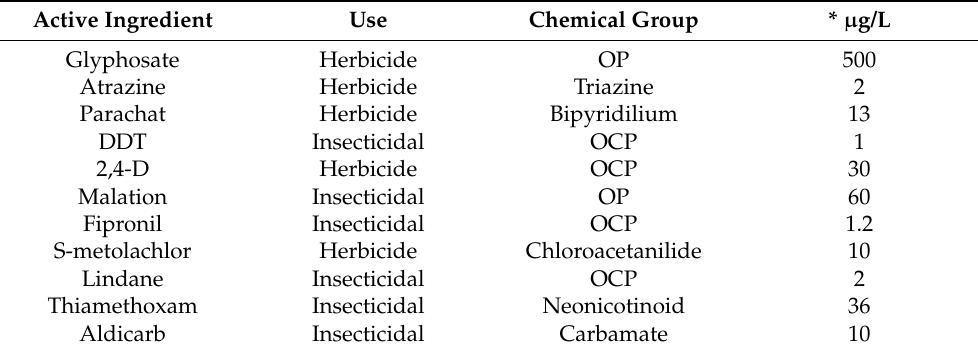
Table 1. Active ingredient and use of some